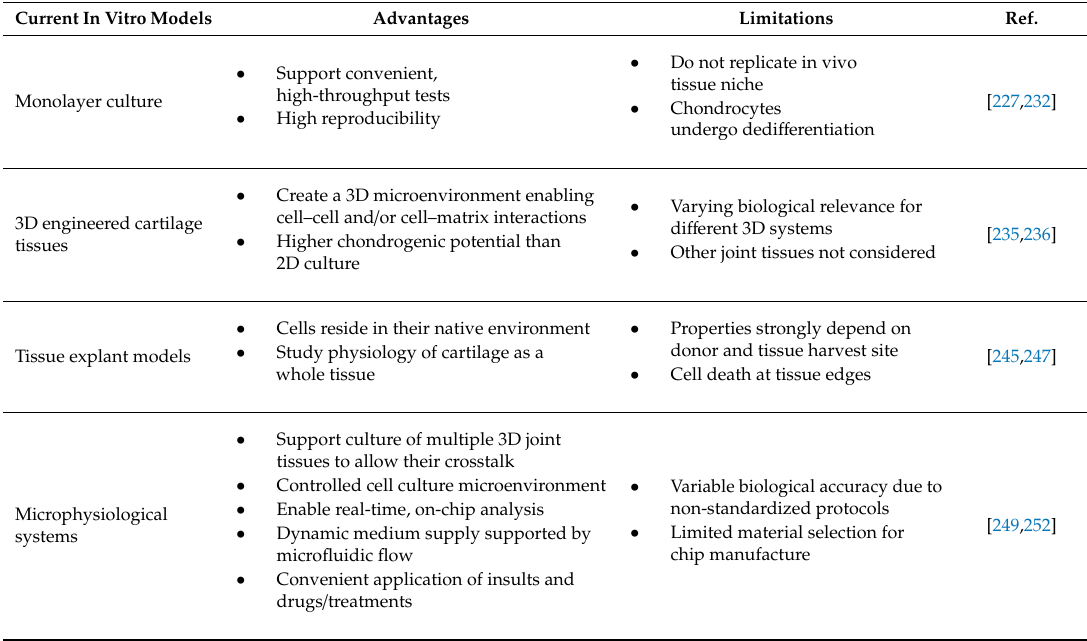
Table 3. Advantages and disadvantages of current in vitro models for OA